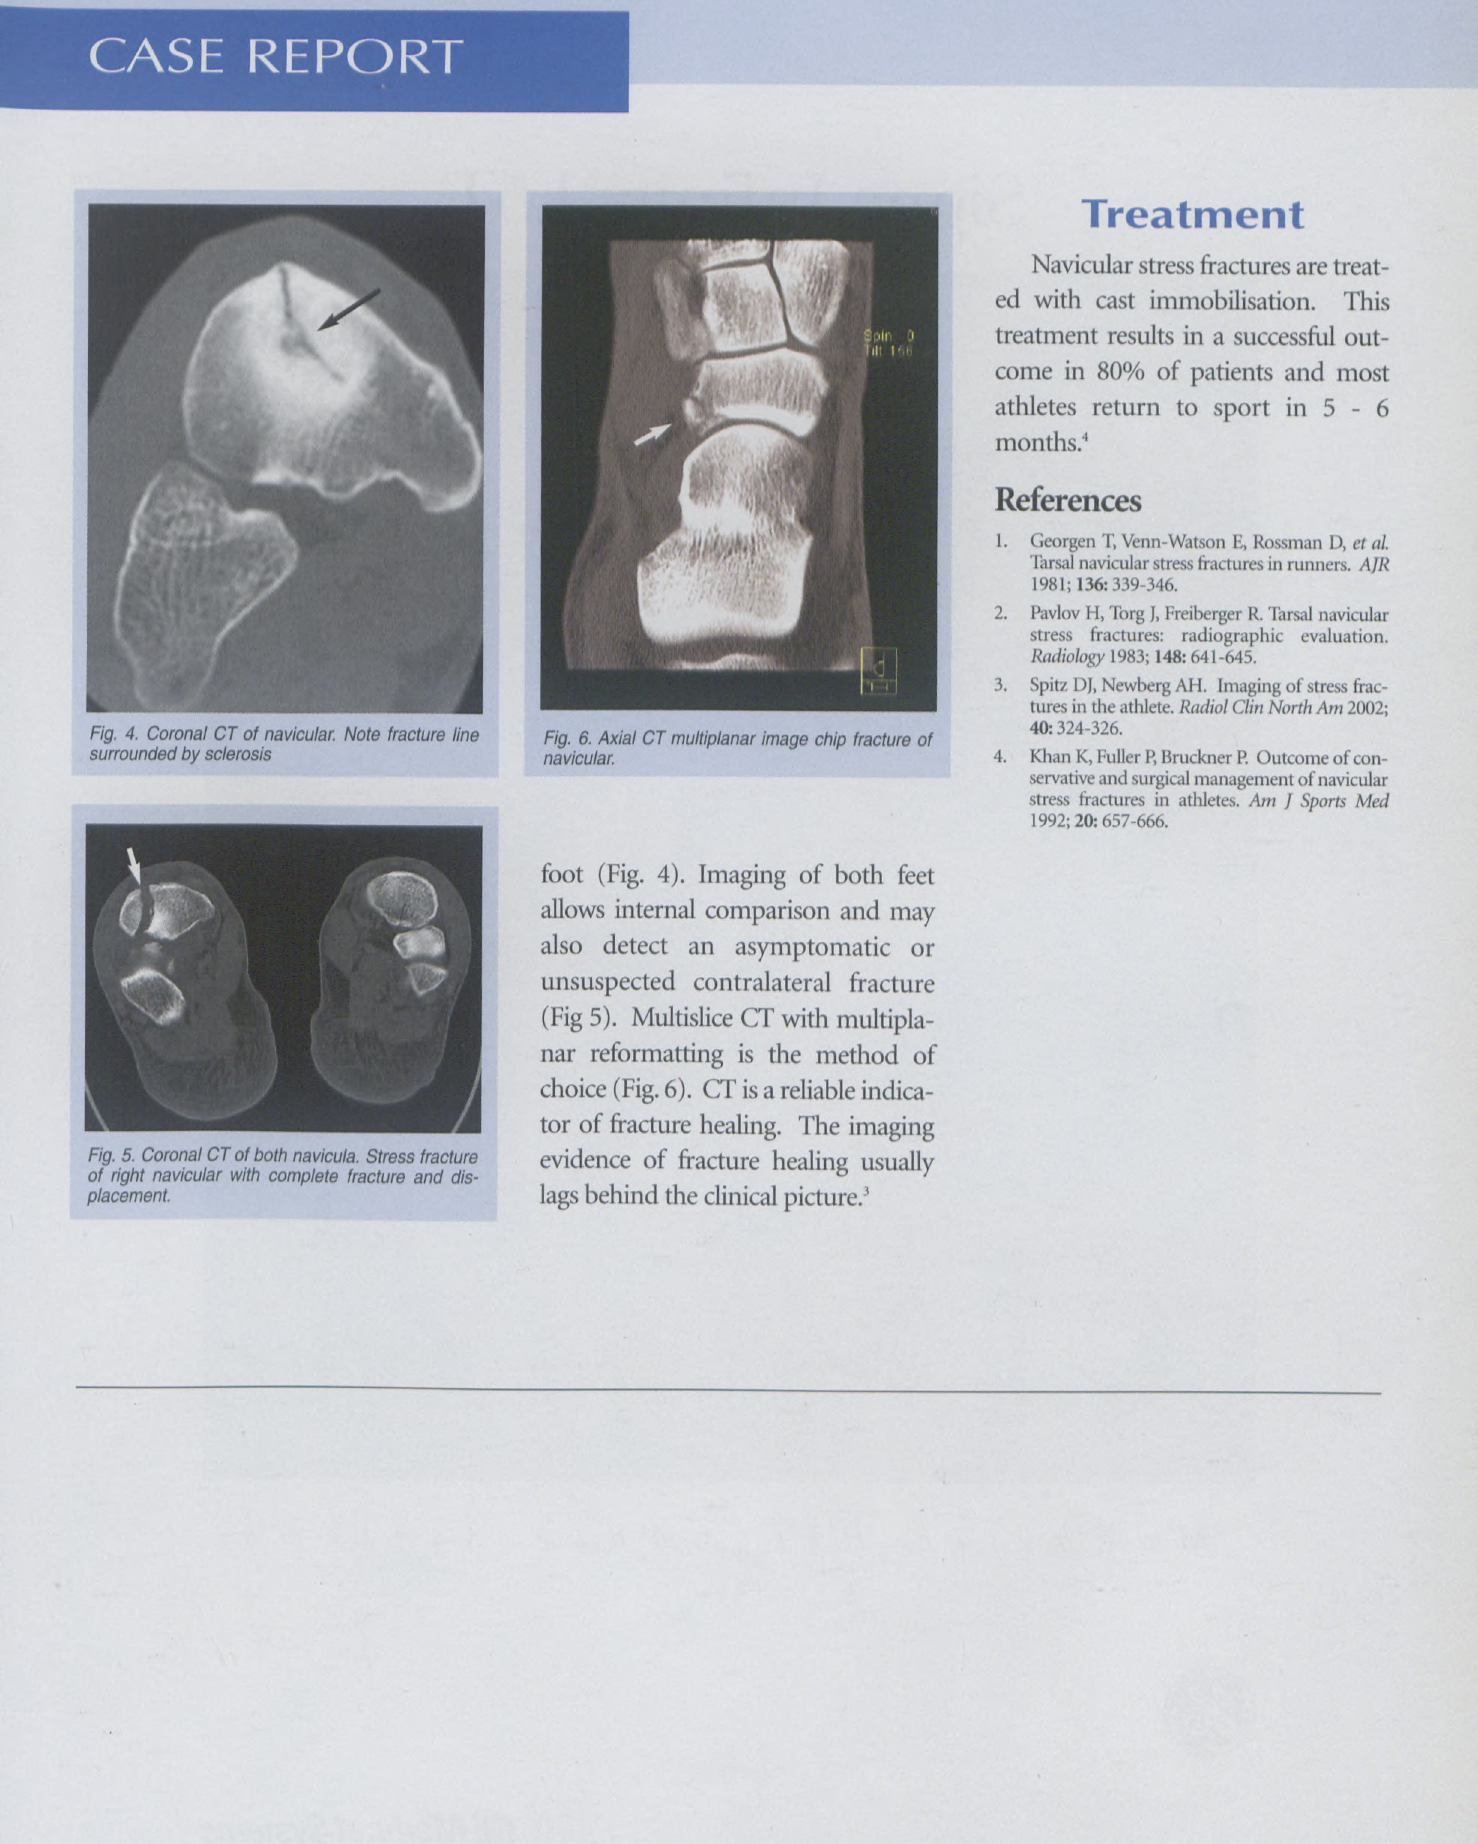
Fig. 5. Coronal CT of both navicula. Stress fracture of right navicular with complete fracture and dis- placement.